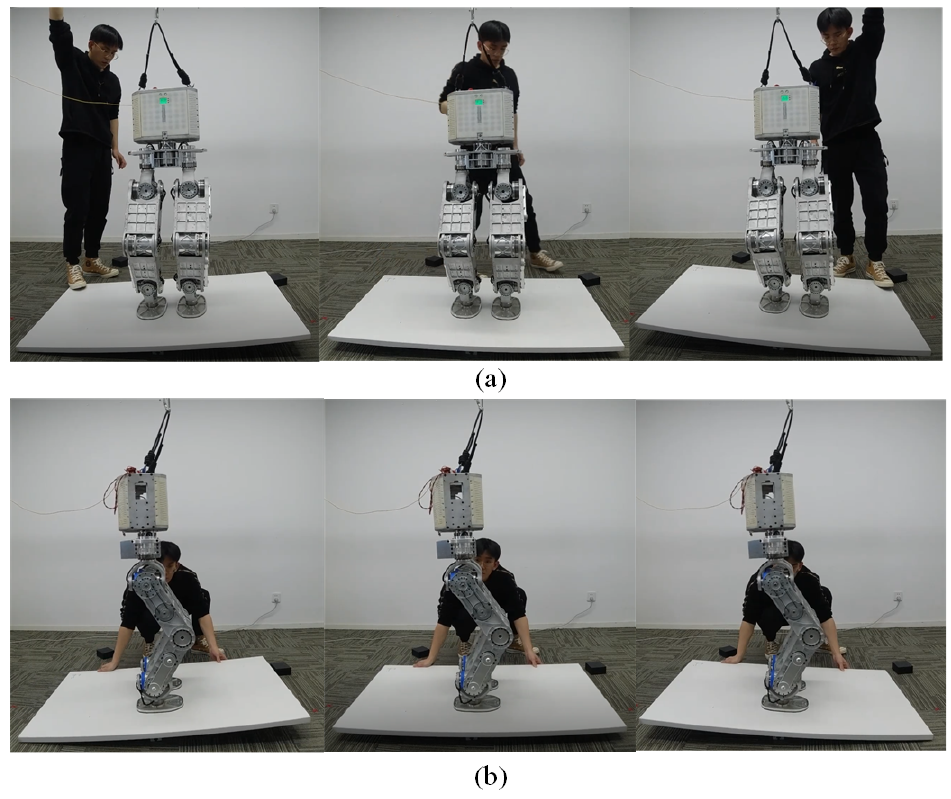
Figure 9. The balancing behaviors when the seesaw rotates along the X axis ( a ) and the Y axis ( b